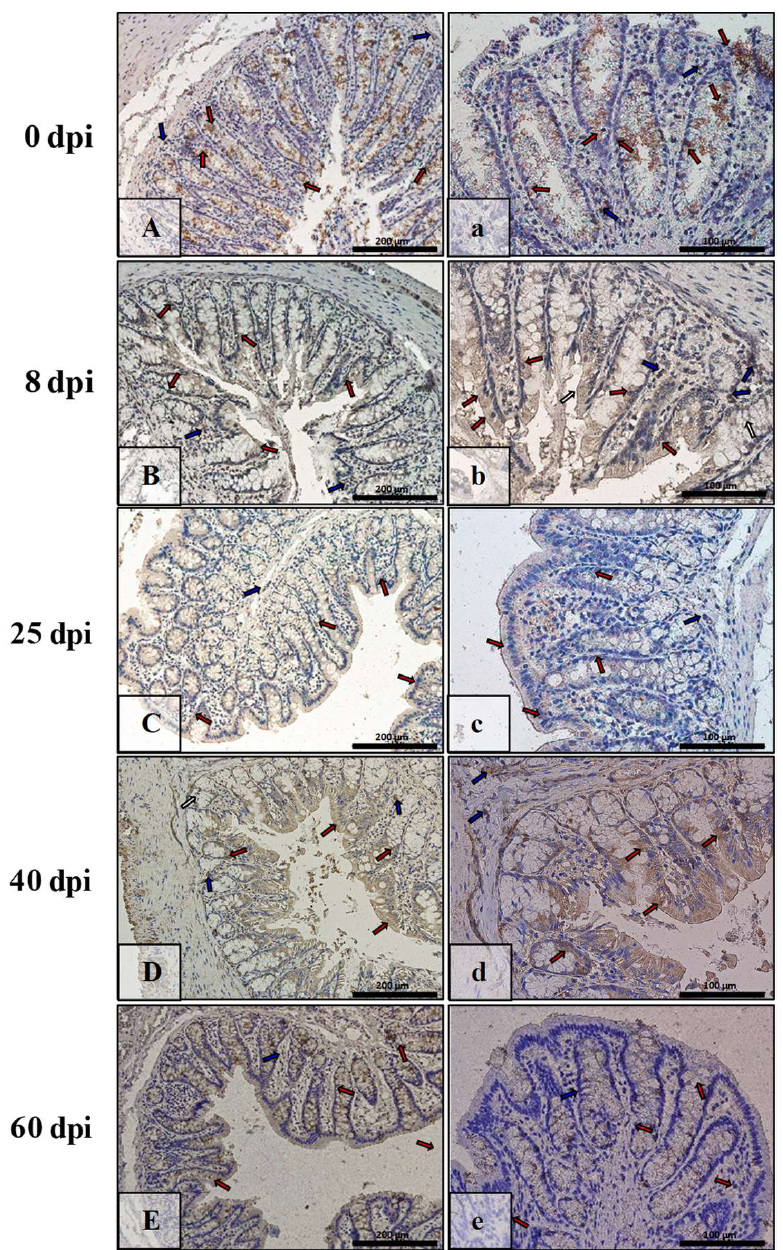
Figure 12. Representative microphotographs showing caspase-3 immunoexpression in the colon of control animals ( A , a ) and on consecutive days ( B , b , C , c , D , d , E , e ) after H. diminuta infection. Positive IHC reaction—brown reaction indicated by arrows: red—epithelial cells of the intestinal villi and crypts, blue and white—cells in the connective tissue lining of the mucosa,. Lens magnification: ×20 ( A – E , scale bar: 200 μm), ×40 ( a – e , scale bar: 100 μm).